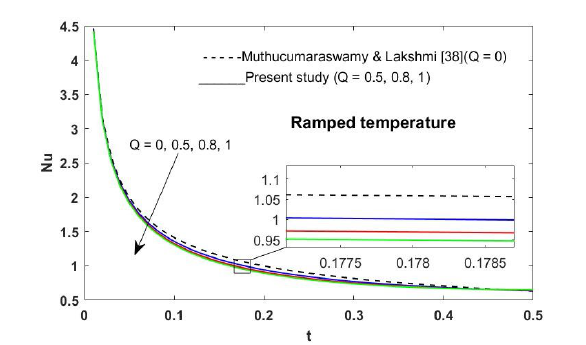
Figure 19: Comparison of the impact of Q on heat transfer at R=0.1 where Pr =